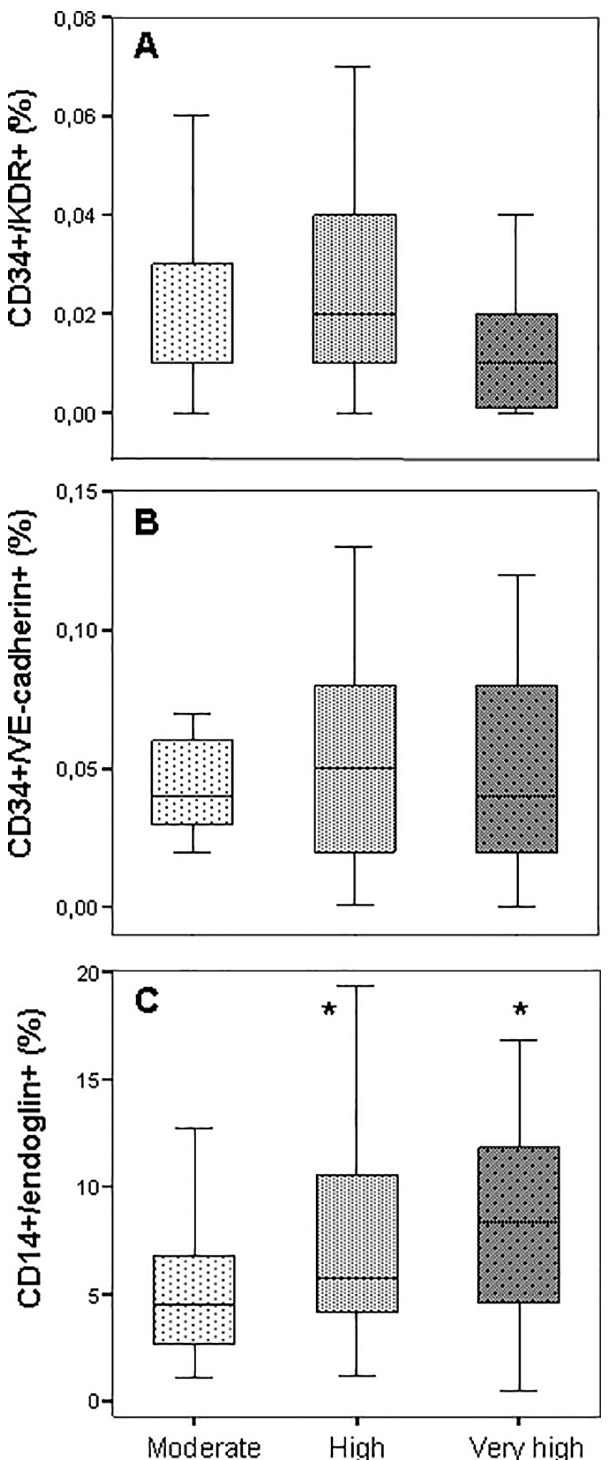
Fig 1. Circulating vascularprogenitor cell levels in hypertensive patients according to cardiovascular risk stratification prior to intensive treatment. We dividedthe patients into three groups accordingto 2007 EuropeanSociety of Hypertension/European Society of Cardiology(ESH/ESC) Guidelines for the management of arterial hypertension [26]: very high-riskpatient were those havingan established cardiovascular or renal disease,high cardiovascular risk when the patient had 3 or more risk factors, organ